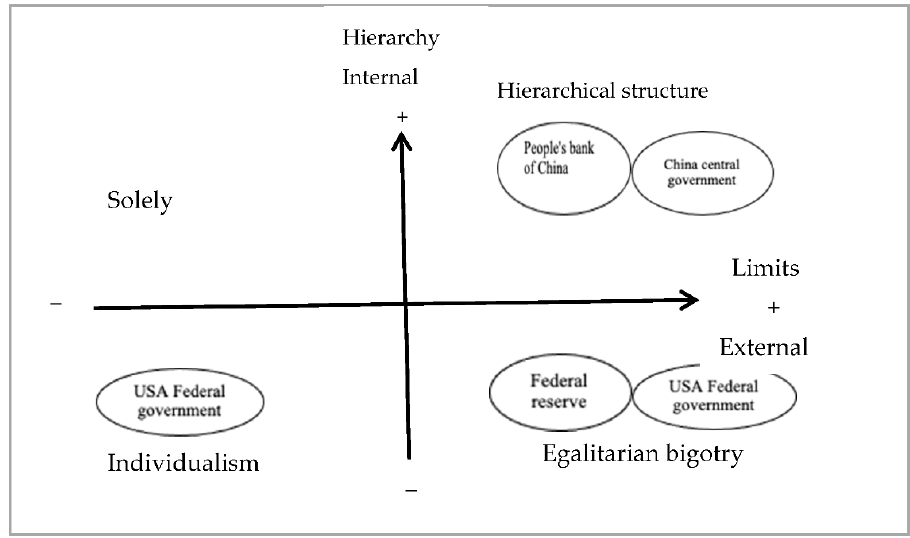
Figure 6. The positioning of the countries and their central banks in the matrix of “cultural the- ory.”